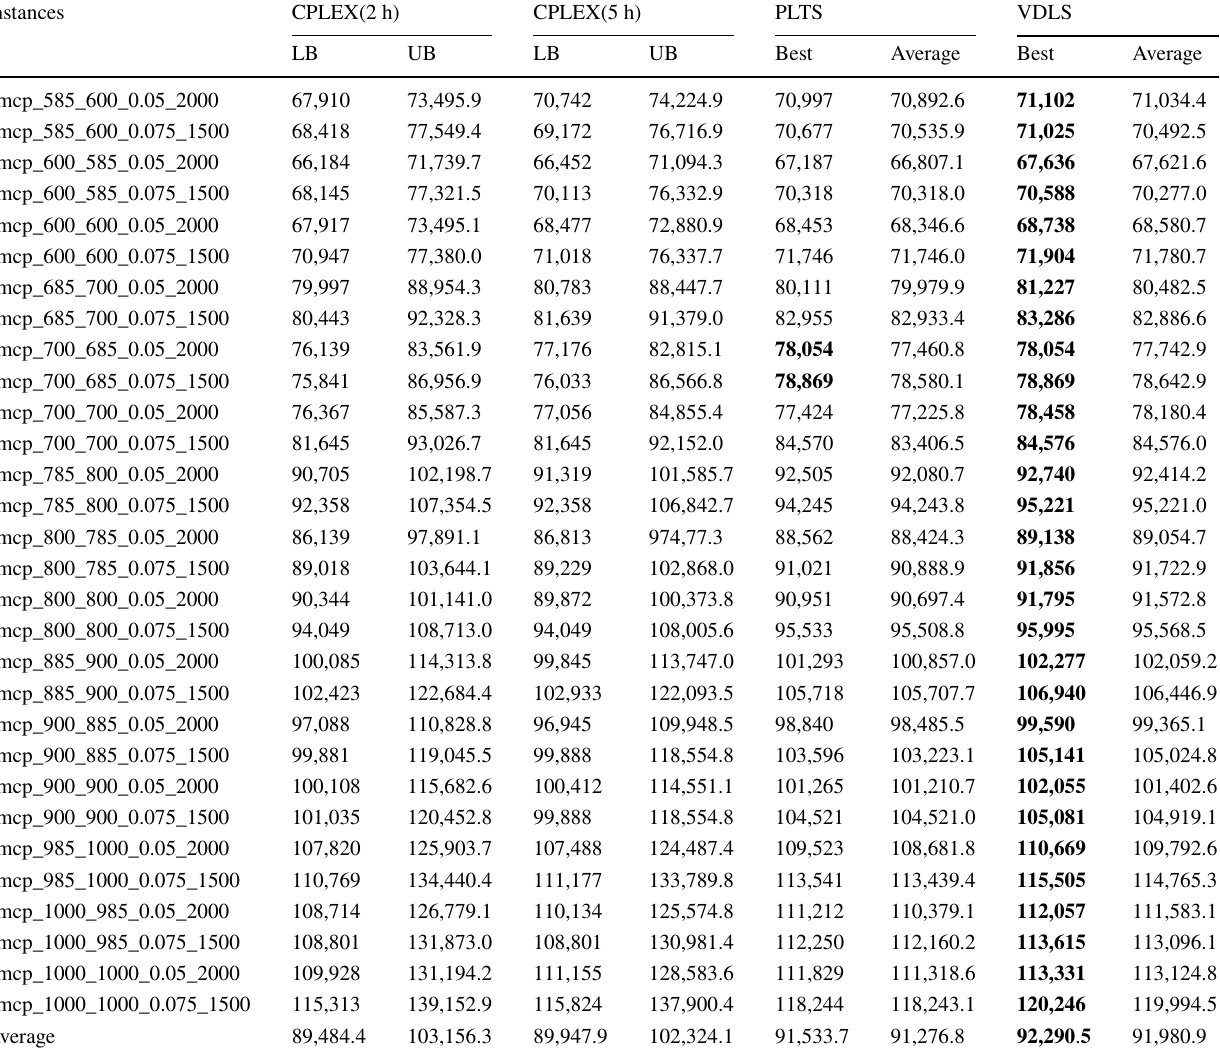
Table 2 Comparison of the PLTS and VDLS with both 10 min of time limit, and the CPLEX solver with 2 h and 5 h of time limit in solving the 30 instances of the first